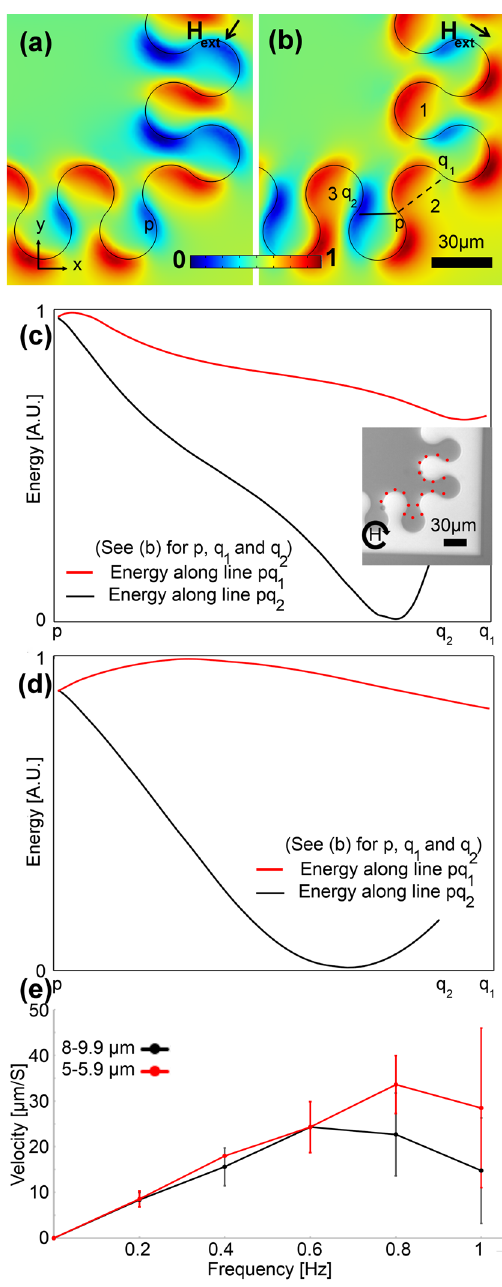
Figure 7. A sample appropriate magnetophoretic bend design for transporting particles inside the bend. ( a , b ) The magnetic energy landscape simulation results above the substrate are illustrated. The blue and red areas stand for the regions with low and high magnetic energies, respectively. Here, we did a min–max normalization to scale the magnetic energy between 0 and 1 (see the legend). The black arrow depicts the in-plane magnetic field direction, in addition to which a vertical bias field is applied. The magnetic energies along the pq 1 and pq 2 lines in ( b ) (i.e., the dashed and solid lines) are plotted with the red and black curves for a particle with a diameter of ( c ) 5 µm and ( d ) 20 µm. The red dotted line in the inset in ( c ) illustrates a sample particle trajectory, where the circular arrow depicts the magnetic field rotation. The goal is to transport the particles from magnet 1 to magnet 3 via magnet 2. We used a linear scale for the magnetic energy plots and we did a min–max normalization, using the minimum and maximum of the magnetic energy along the pq 1 and pq 2 paths, to scale the energy between 0 and 1. ( e ) The particle velocity versus frequency of the externally applied magnetic field is plotted with the black and red curves for two particle sets with sizes in the ranges of 5–5.9 µm and 8–9.9 µm, respectively. The error bars show standard